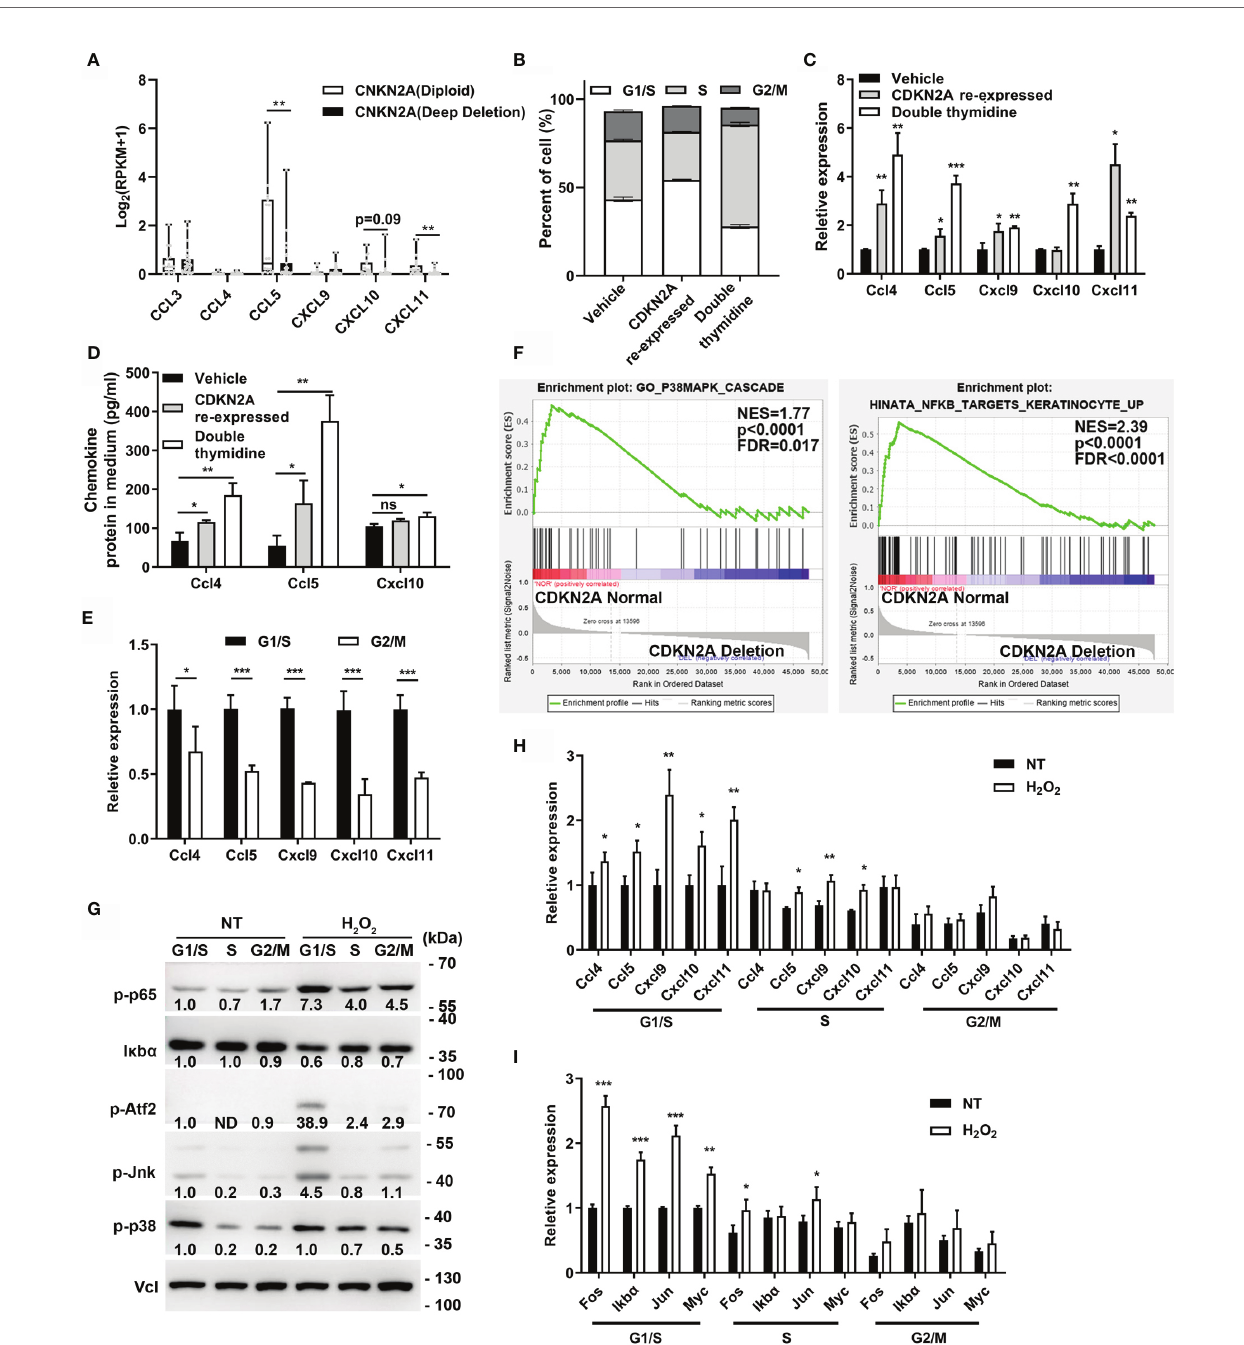
FIGURE 3 | CDKN2A enhances chemokine expression. (A) Chemokine expression in CDKN2A Diploid and Deep deletion melanoma cell lines. (B) Cell cycle analysis of vehicle, double thymidine treated B16F0 cells and CDKN2A re-expressed B16F0 cells. (C) The mRNA expression of chemokine Ccl4, Ccl5, Cxcl9, Cxcl10, and Cxcl11 expression in control, CDKN2A re-expressed and double thymidine treated B16F0 cells. (D) ELISA analysis of the chemokine Ccl4, Ccl5, and Cxcl10 expression in control, CDKN2A re-expressed and double thymidine treated B16F0 cells. (E) The mRNA expression of chemokine Ccl4, Ccl5, Cxcl9, Cxcl10, and Cxcl10 in B16F0 cells arrested at G1/S and the cells arrested at G2/M phase. (F) The GSEA analysis of the gene expression in P38/MAPK and NF- k B pathway in patients with normal CDKN2A or CDKN2A deletion in TCGA-SKCM cohort. (G) The expression of protein in p38/MAPK and NF- k B pathway in B16F0 cells arrested at G1/S phase, S phase, G2/M phase with or without H 2 O 2 treatment. (H) mRNA expression of chemokine Ccl4, Ccl5, Cxcl9, Cxcl10, and Cxcl11 in B16F0 cells treated with